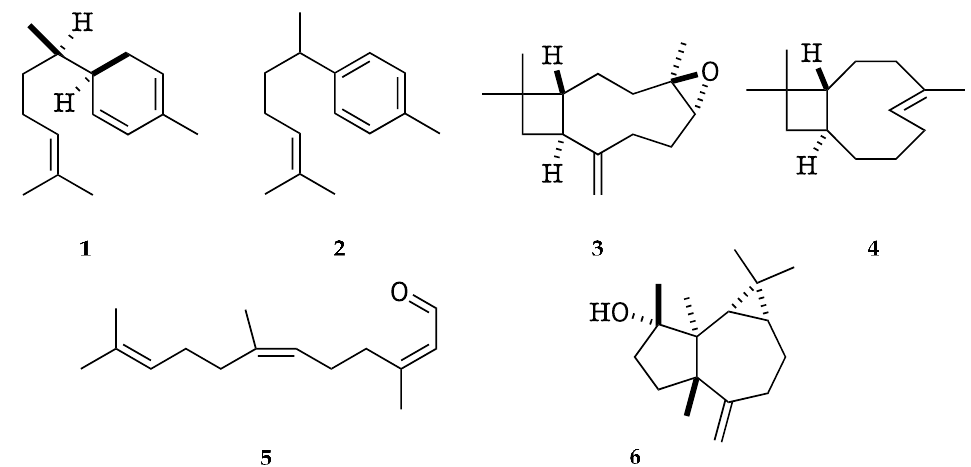
Figure 2. Major identified compounds in the EO of K. longipetiolata. Table 1. Chemical analysis of Kaunia longipetiolata essential oil on 5%-phenyl-methylpolysiloxane and polyethylene glycol GC columns. The progressive numbers are referred to peaks in Figures 4 and 5.